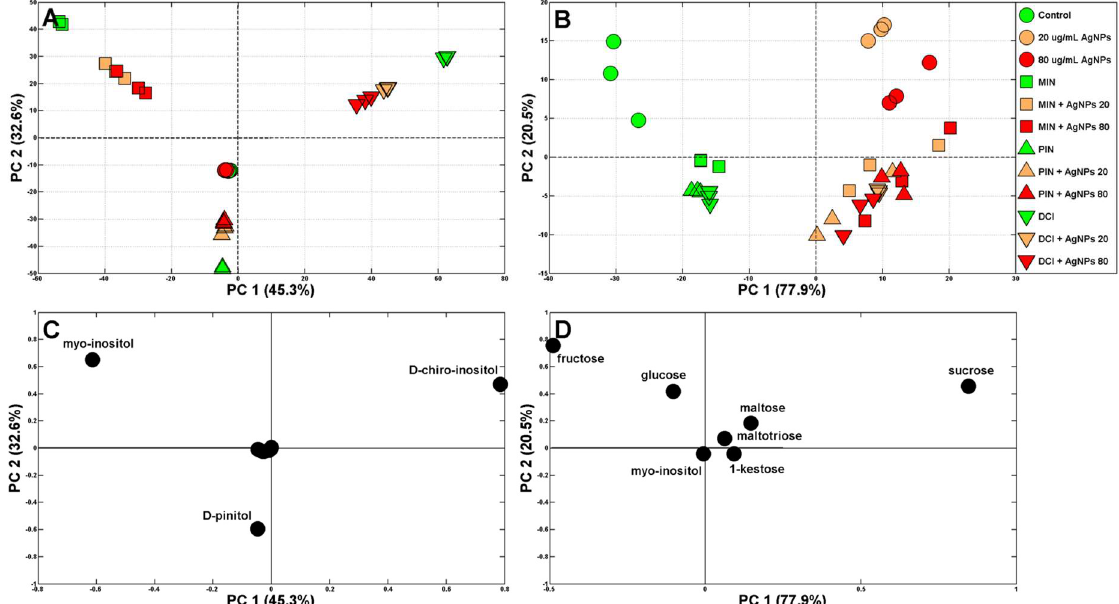
Figure 4. Principal component analysis (PCA) of soluble carbohydrate profiles (with ( A ) and without ( B ) exogenous cyclitols) of wheat seedlings grown in water (control), solutions (green symbols) of myo -inositol (MIN), D -pinitol (PIN) and D - chiro -inositol (DCI) and mixtures of cyclitols (at 100 mM each) with (Bio)Ag NPs at 20 and 80 mg/L (orange and red symbols, respectively). Symbols : circles—control samples and those treated with (Bio)Ag NPs only, squares—samples treated with MIN and MIN + Ag NPs, triangles— samples treated with PIN and PIN + Ag NPs, inverted triangles—samples treated with DCI and DCI + Ag NPs. The PCA loading plots of the soluble carbohydrates are shown in figures ( C , D ).